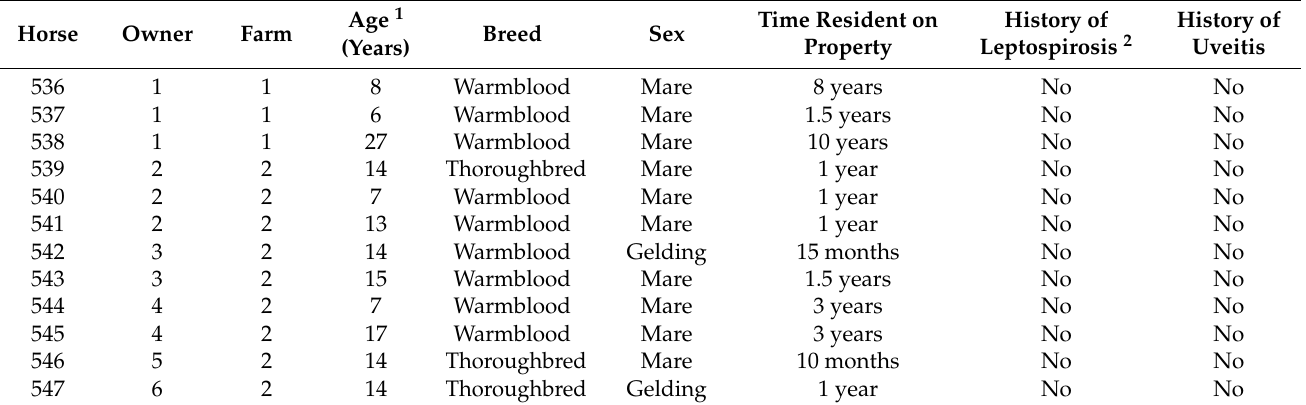
(Figure 1). At the time of sampling, the horses on Farm 1 were not paddocked together but had been during the previous 12 months. Nine horses, across five owners, were located on Farm 2. On Farm 2, each owner generally had a paddock each for their horses to share, however, horses 546 and 547 had shared a paddock in the last 12 months. Horses on Farm 2 were frequently ridden together, and the owners had access to the farm and neighbouring forest for riding. Table 1. Details of the horses tested for leptospiral antibodies, located near an outbreak of leptospirosis in alpacas. Information on the horses was collected at the time of testing.